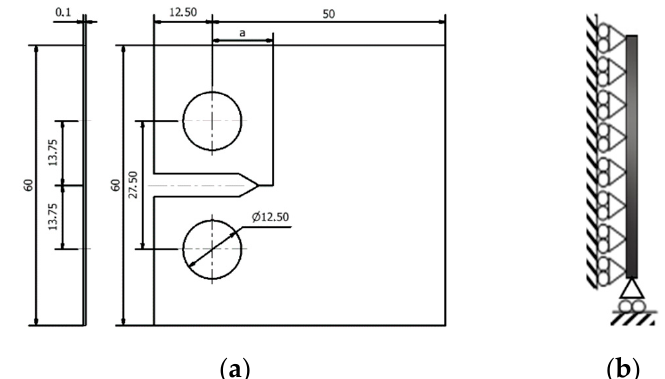
Figure 1. ( a ) Compact tension (CT) specimen modelled for AA2024-T351, with dimensions in mm. ( b ) Plane stress boundary conditions.